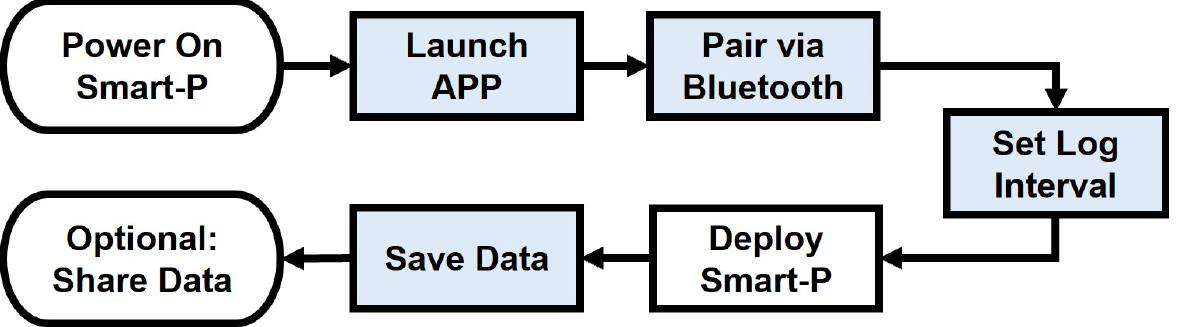
Figure 3. Step-by-step operation of Smart-P for measuring PM 2.5 concentrations. Shaded boxes indicate app operations.